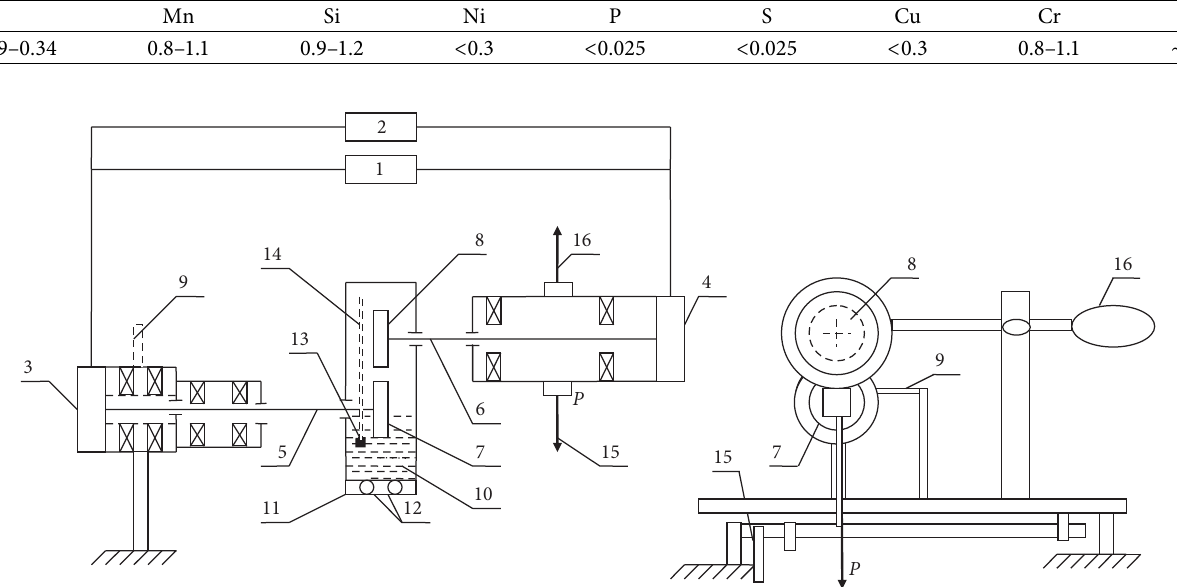
Figure 1: Te scheme of the software-hardware complex for evaluating the tribotechnical characteristics of